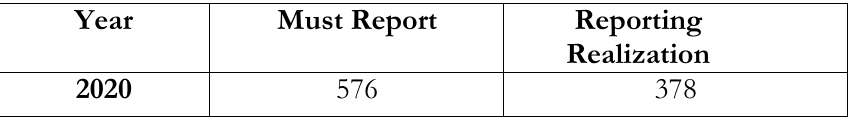
Table.3 Targets and Realization of Taxpayer Compliance at KPP Pratama North Bekasi in